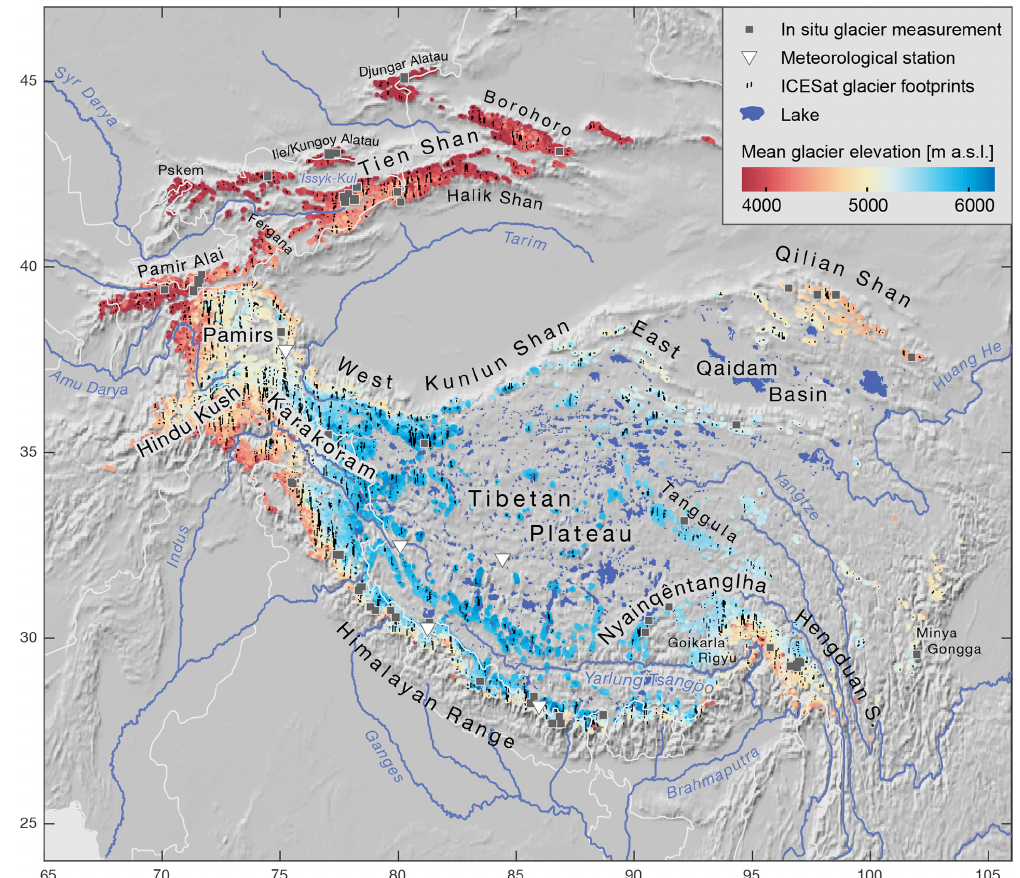
Figure 1. Mountain ranges and major rivers in High Mountain Asia, with meteorological stations (triangles), lakes on the TP and in the Qaidam Basin (dark blue) and ICESat glacier samples (black dots) used in this study. Dark grey squares show all in situ glacier mass balance measurements done at some point during the last decades (WGMS, 2016), and RGI glaciers are coloured according to their mean